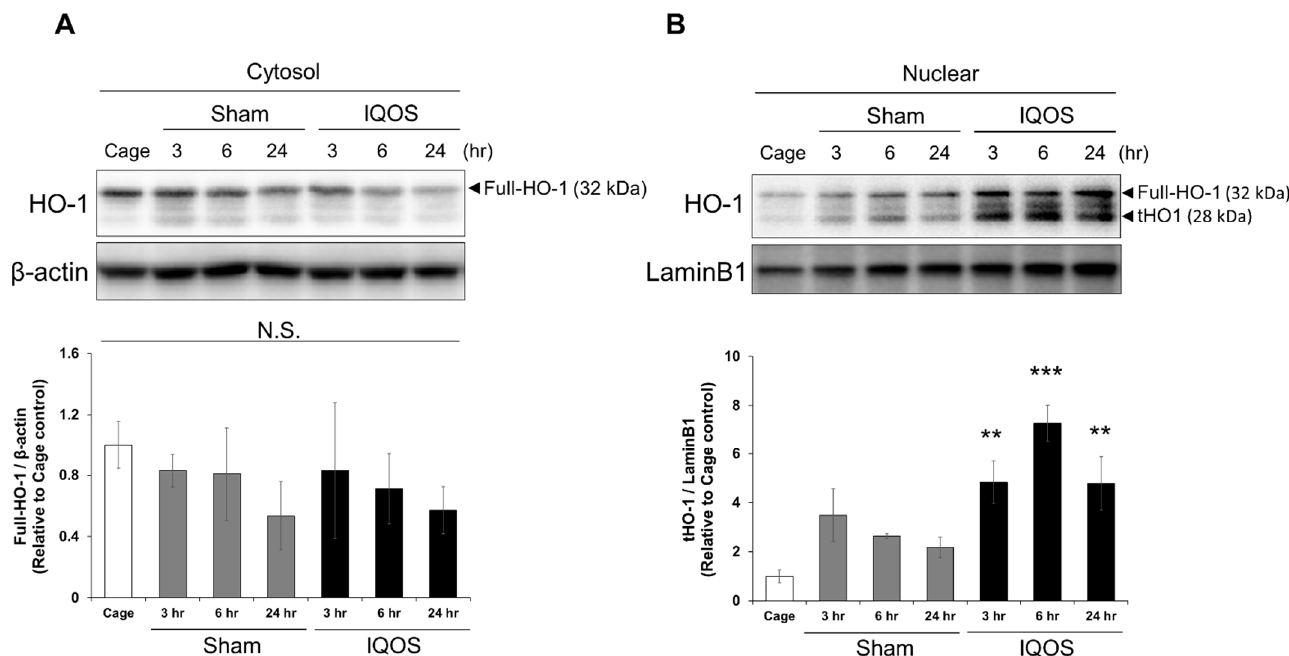
Figure 4. Alterations in HO-1 protein localization in murine lungs by exposure to IQOS. ( A ) Expres- sion analysis of HO1 in the cytoplasmic fraction of murine lungs from cage controls, sham controls, and at various times after exposure to IQOS. The density of HO-1 bands was measured, and the expression ratio normalized to β -actin was calculated and expressed as fold-change relative to cage control mice. ( B ) Expression analysis of nuclear HO-1 in the lungs of at cage controls, sham controls, and at various times after exposure to IQOS. The density of HO-1 bands was measured, and the expression ratio normalized to LaminB1 was calculated and expressed as fold-change relative to cage control mice. ** p < 0.01, and *** p < 0.001 versus cage control group. N.S.: not significant. N = 3. Full-HO-1: full-length HO-1; tHO-1: truncated HO-1.